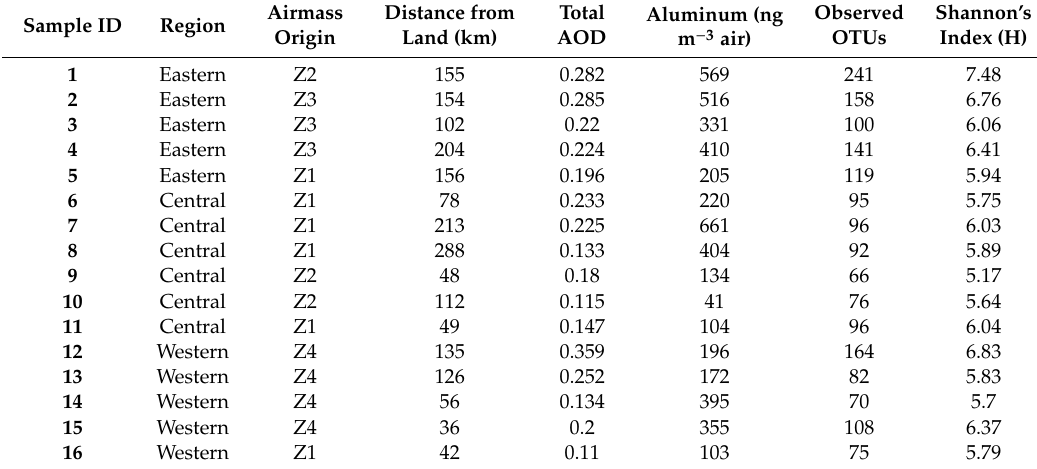
Table 1. Sample ID, region of the MS samples were collected from, airmass origin of samples based on HYSPLIT back trajectory models (Z1 = Western Europe, Z2 = Eastern Europe, Z3 = Mediterranean Sea, and Z4 = Northern Africa), distance between the sampling site to the closest landmass or island (km), total aerosol optical depth (AOD), aluminum concentrations (ng m − 3 air), number of OTUs observed, and Shannon’s Diversity Index (H) are shown for each